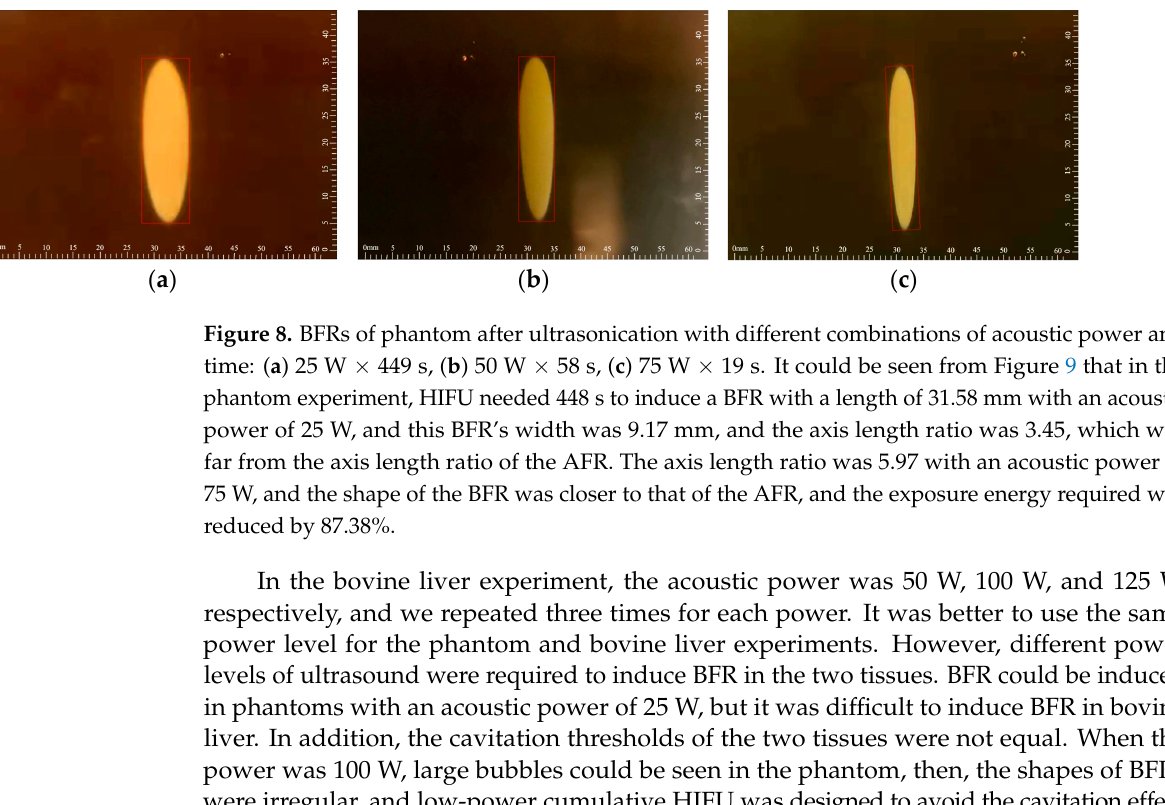
Figure 7. ( a ) Lengths ( b ) widths ( c ) axis length ratios of the BFRs, and ( d ) energy after ultrasonication with di ff erent combinations of acoustic power and time in bovine liver simulation.